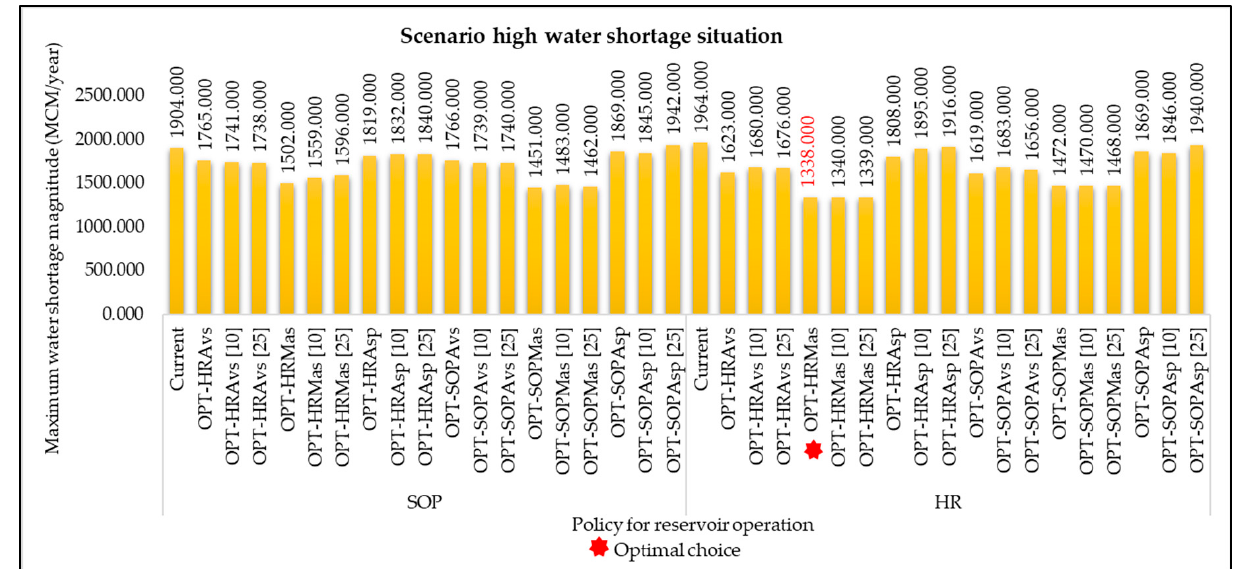
10 of 17 Figure 8. Optimal choice for operating rule curves under normal water scarcity scenario. 3.1.2. Scenario of High Water Shortage The maximum water shortage values for each rule curve are shown in Figure 9. The figure shows that when network reservoirs experience a water shortage, the adverse impact seems to be very serious. The rule curve that the reservoir should choose to apply is the rule curve with the objective aim of achieving the minimal maximum water shortage with the HR criterion (OPT-HRMas). This means that the decision makers must apply this rule curve to release water with the HR criterion threshold, which will result in the lowest maximum water shortage of 1338.00 MCM/year. The results showed that when the HR water discharge threshold was selected in